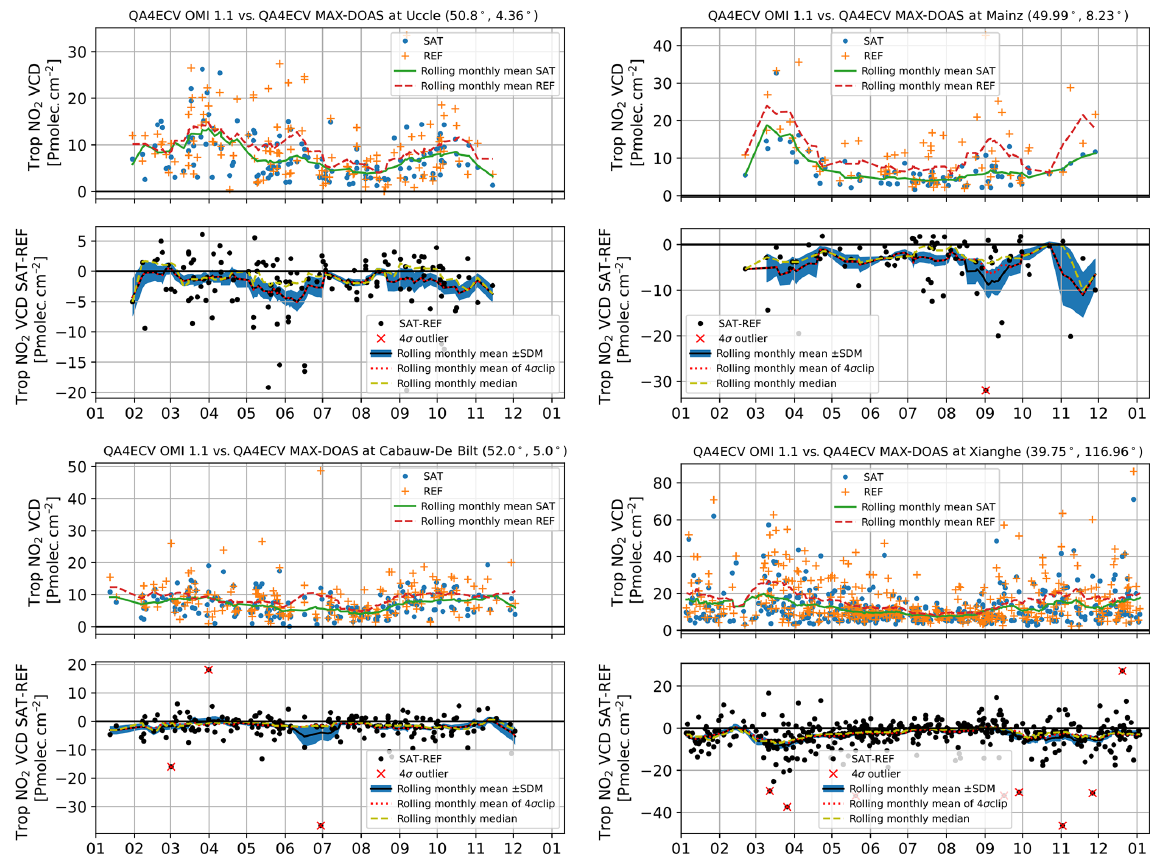
Figure 11. As in Fig. 10 but for the Uccle, Mainz, Cabauw/De Bilt and Xianghe sites.